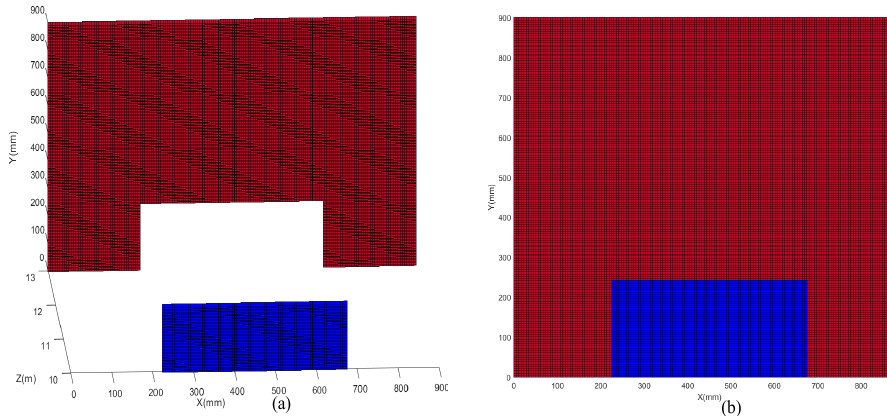
Figure 12. The depth image of the target with 10 × 10 pixels.